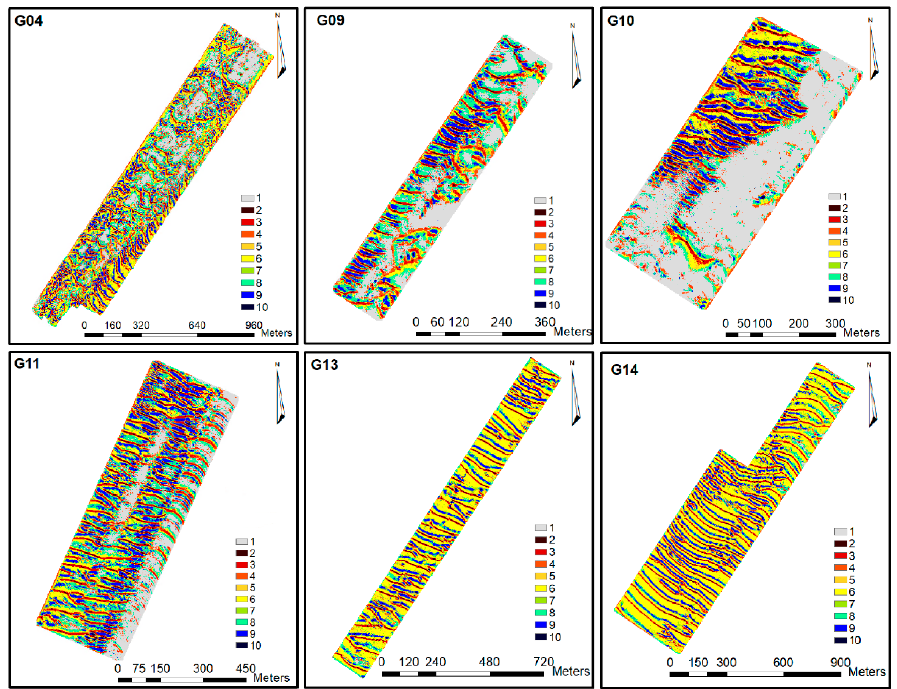
Figure 9. Geomorphon surface of the DBM illustrated in Figure 8, where 1 represents flat, 2